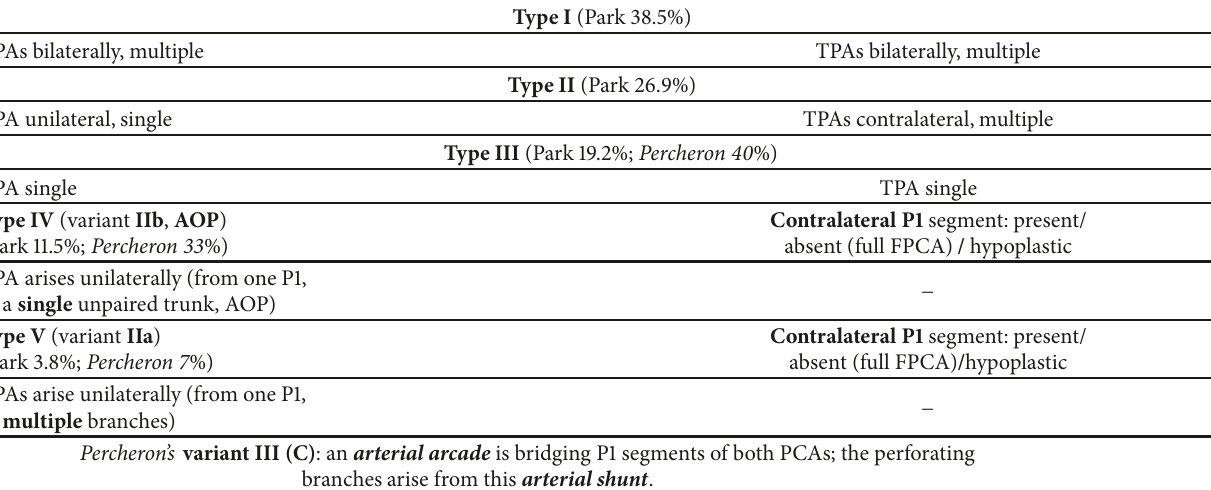
Table 2: Variable branching patterns and origin of the TPAs, emerged unilaterally or bilaterally from the P1 arterial segment. Type I (Park 38.5%)